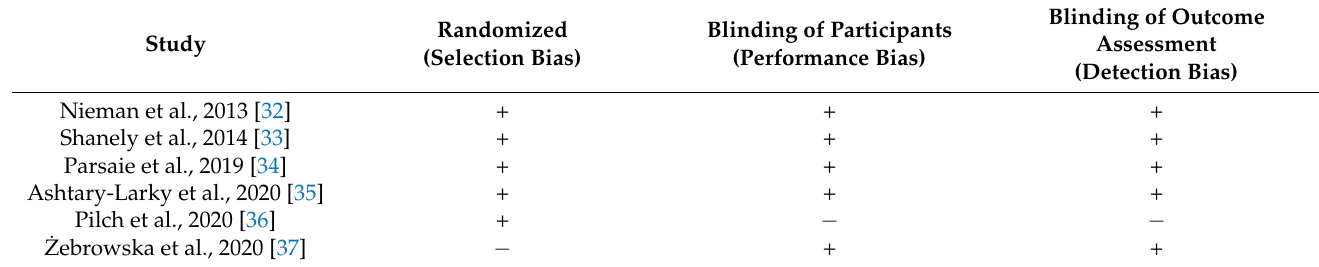
Table 1. Bias risk of different aspects for the selected